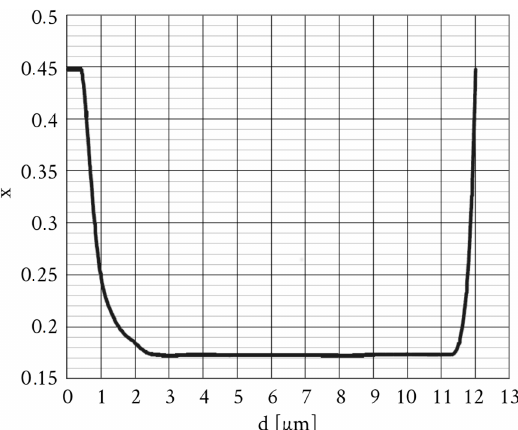
Figure 2. A content of Cadmium in the epitaxial layer studied as a function of the distance from the sample’s surface (at d =